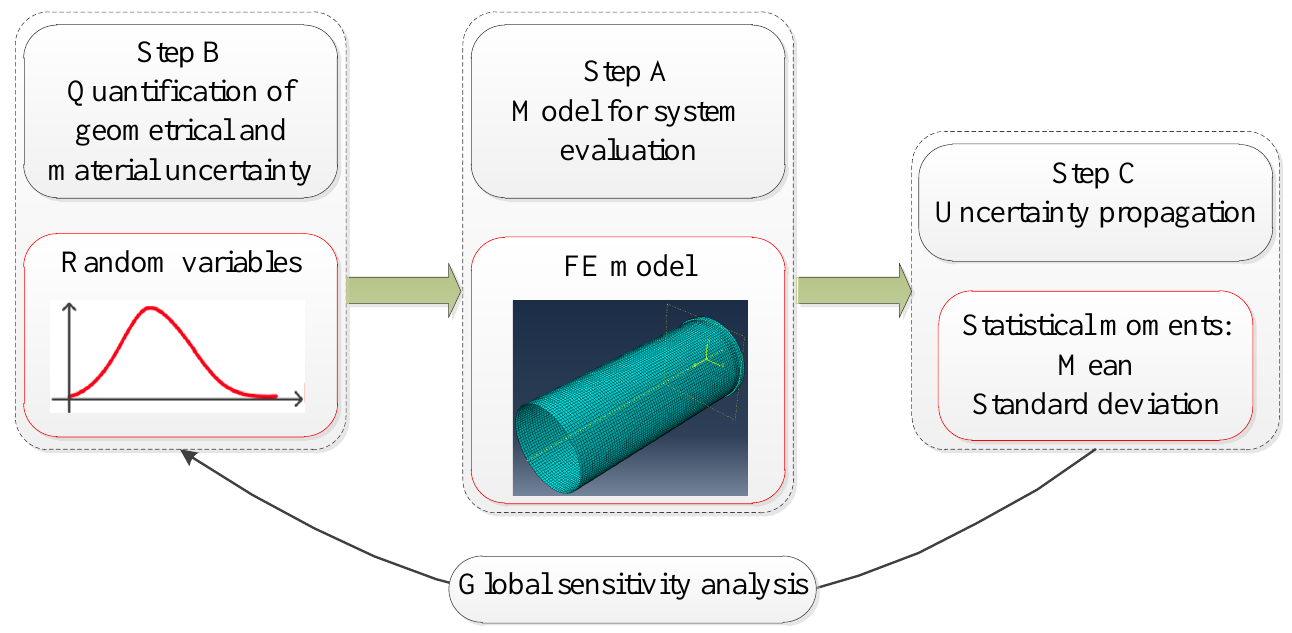
Figure 4. General framework for uncertainty quantification.